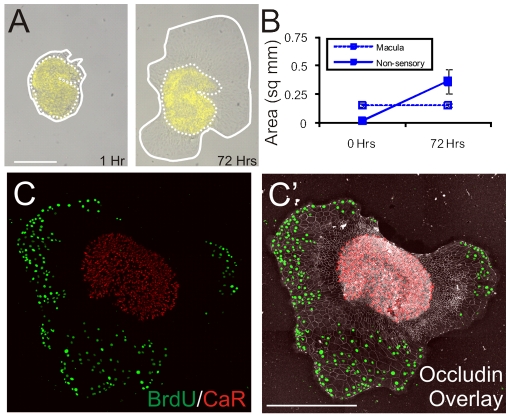
Cells from the macula of 2-week-old mouse utricles lose the ability to change shape and enter S-phase.(A) Images of a delaminated utricular epithelium from a P15 mouse cultured for 72 hours on a thin layer of Matrigel taken 1 hour after plating (left) and after 72 hours in culture (right). The epithelium was preincubated in FM1–43 to label the hair cells (yellow), and both the edge of the utricular epithelium (solid line) and macula (dashed line) are marked. (B) Quantification of the total area of utricular epithelia and maculae from P15 mice cultured for 72 hours on thin Matrigel. Although the total area of utricular epithelia increases over 72 hours, the area of maculae remains unchanged (101%±9% of initial size after 72 hours; n = 5). (C) Z-projected confocal image stack of a delaminated utricular epithelium from a P15 mouse cultured for 72 hours on thin Matrigel and immunolabeled for BrdU (green) and the hair cell marker, Calretinin (red). An α-occludin overlay (C′) shows the extent of cell shape change in the non-sensory epithelium. All BrdU+ nuclei were in the spread regions of the non-sensory epithelium. The macula did not spread or contain BrdU+ nuclei.